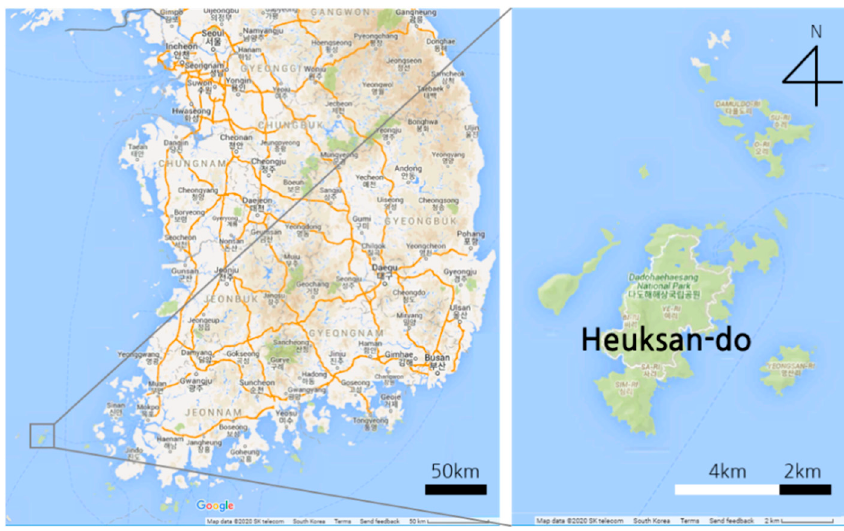
Figure 1. Location and map of the study area, Heuksando, Korea.